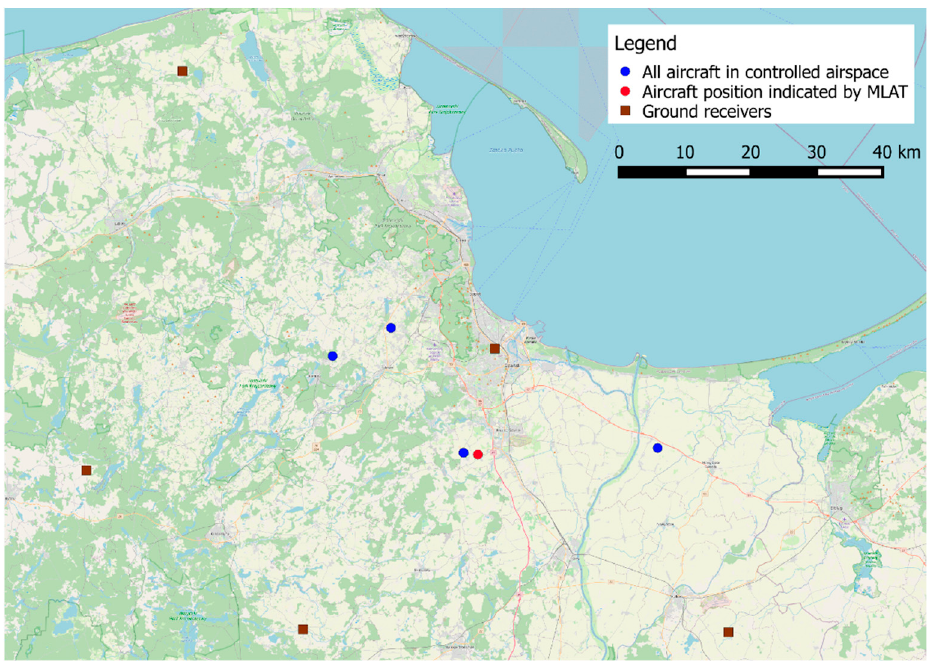
Figure 22. Exemplary map with single result of aircraft position estimation using voice transmission in VHF band.